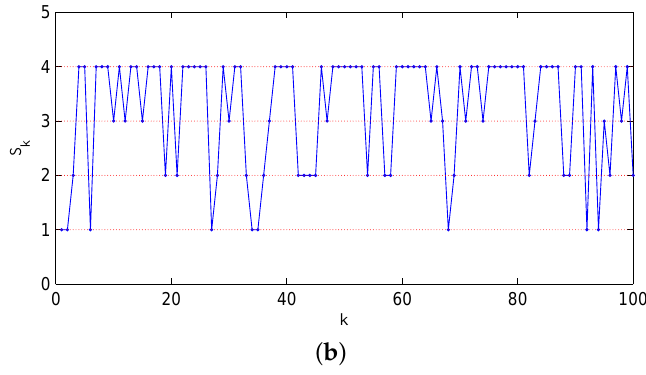
Figure 6. The error covariance matrix P k and channel state S k with ( q 1 , q 2 ) = ( 0.6, 0.8 ) : ( a ) The error covariance; ( b ) the associated channel